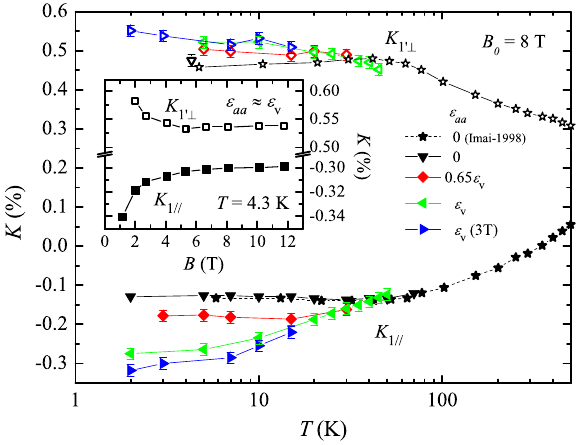
Fig. 1 Temperature-dependent 17 O NMR Knight shifts, for different fi elds and strains. 17 O shift measurements recorded under zero strain, critical strain, and an intermediate strain are shown in the main panel. Note that for the critical strain, the effects of the singularity are more substantial in K 1 ∥ than in K 1 0 ? . Error bars are determined by the NMR linewidth. Inset: Shift vs fi eld data from ref. 25 . The shifts at the critical strain ε v exhibit a strong fi eld dependence, observable for suf fi ciently low temperatures, that is associated with the Zeeman split of the singularity.